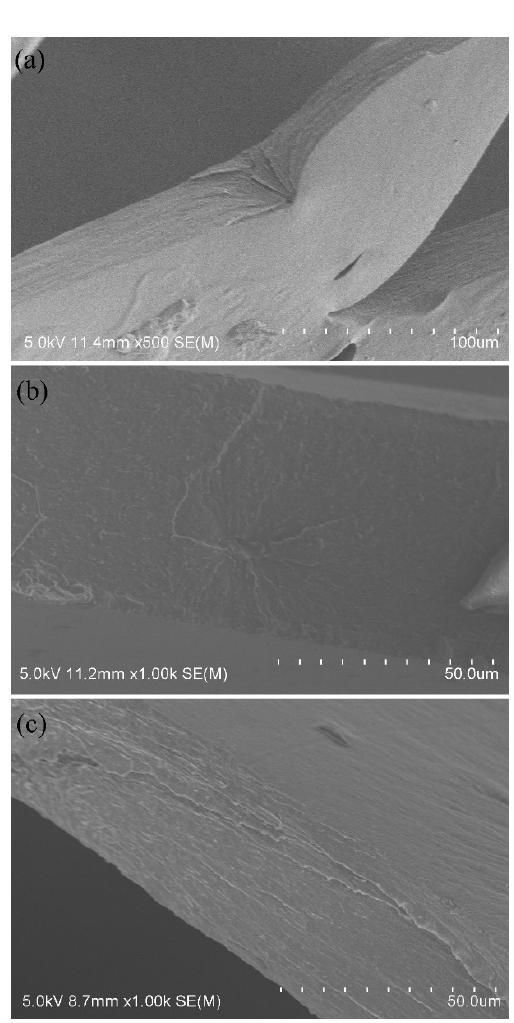
Figure 8. SEM images of the cross sections of the ACS ( a ), HS ( b ) and HCS ( c ) films.